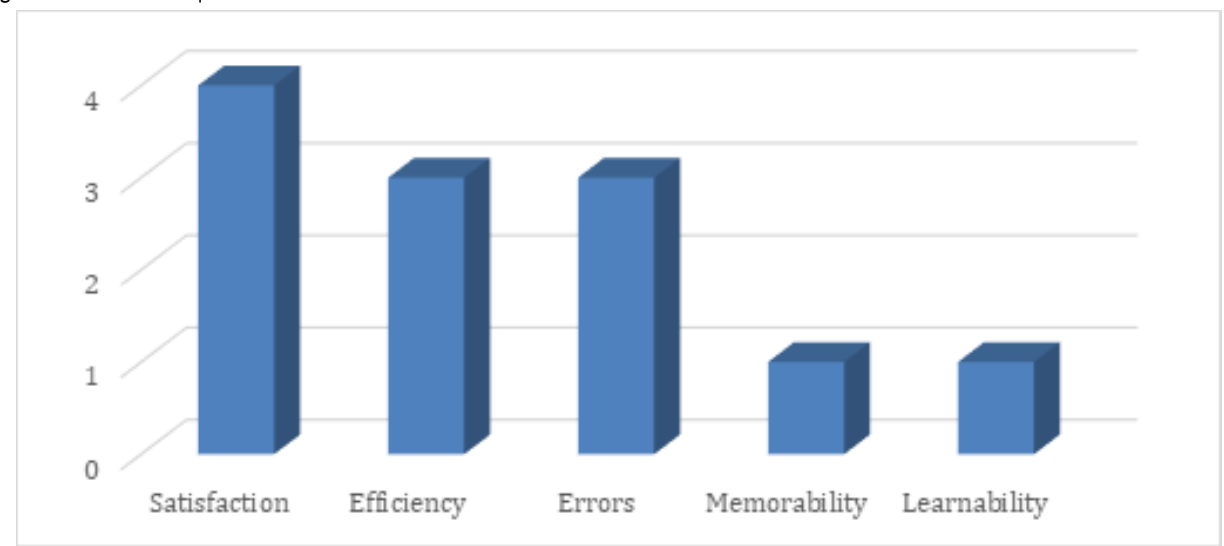
Figure 10. Number of top concerns from